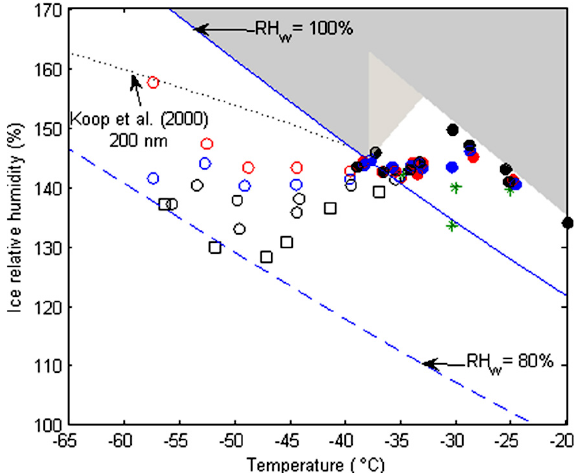
Fig. 3. Conditions for ice nucleation on 5% of SD particles as a function of temperature for sizes: 200nm (red), 300nm (blue), 400nm (black circles) with flow ratios of 7.0:2.5 lpm in the DMA. Black squares are for 600nm data with flow ratios of 4.0:2.5lpm in the DMA. Points represent 5% of the particles activating as ice crys- tals. Open symbols refer to data collected with the laboratory unit, filled symbols refer to data collected in the aircraft unit. Green stars represent conditions for ice nucleation on 1% of polydisperse SD particles during ICIS. The dark gray shading indicates the region where droplets are known to be counted by the OPC in the CFDC systems. The light gray shading indicates the transition where the state of the particle counted by the OPC is ambiguous. Water satura- tion, RH w = 80% and the conditions for which 200nm (NH 4 ) 2 SO 4 particles nucleate ice according to Koop et al. (2000) are indicated in the figure for